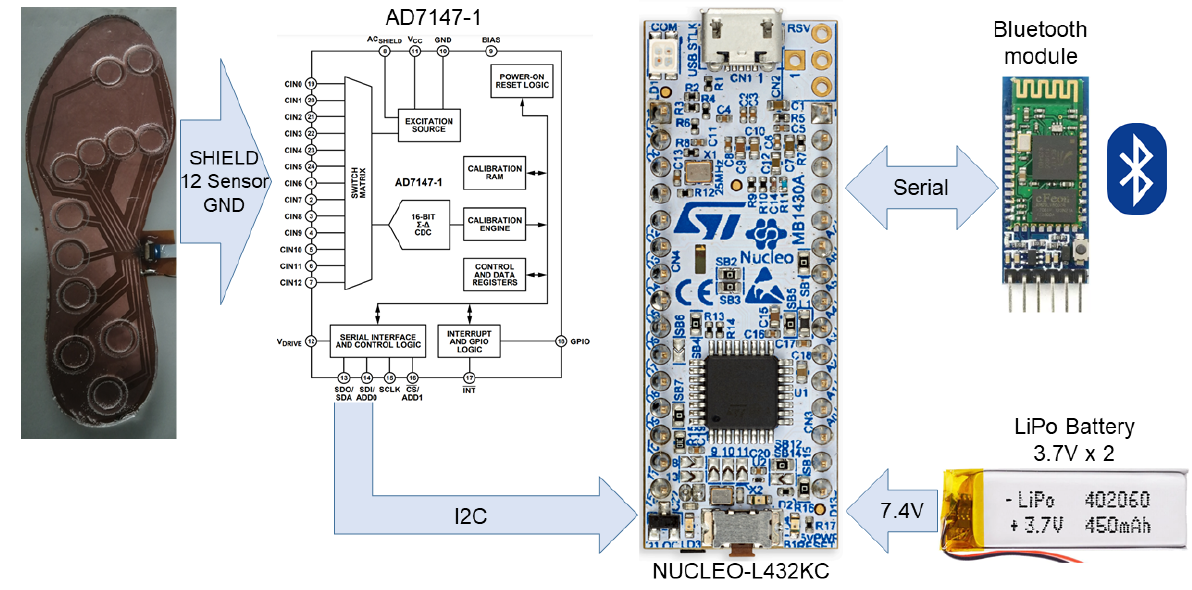
Figure 3. Block diagram of the main components of the plantar insole